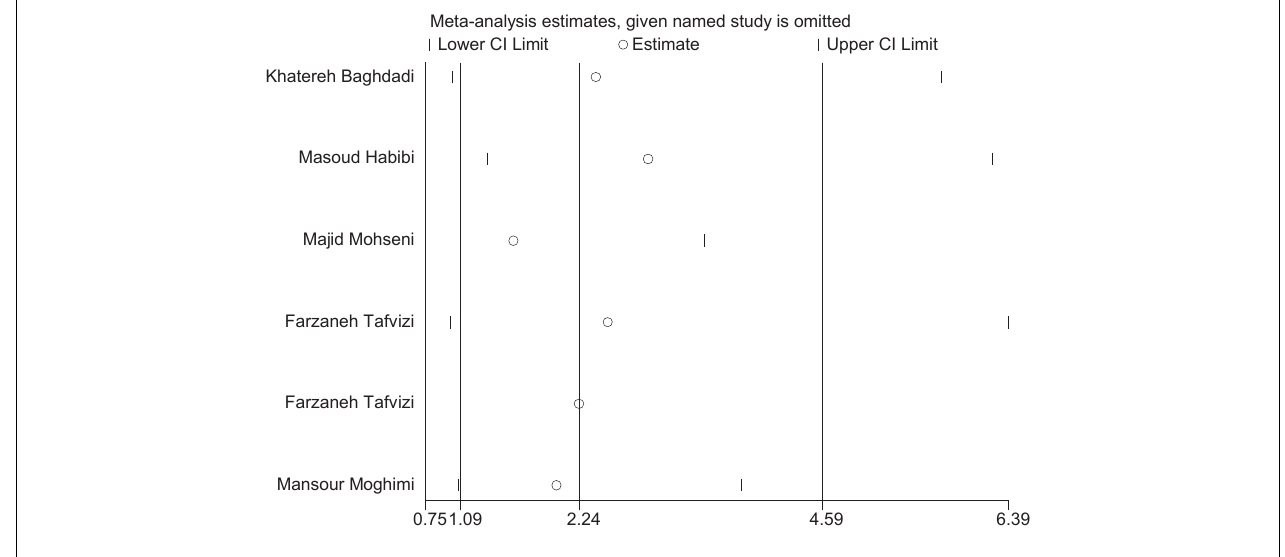
FIGURE 4 | Sensitivity analysis of the primary studies included in the meta-analysis.